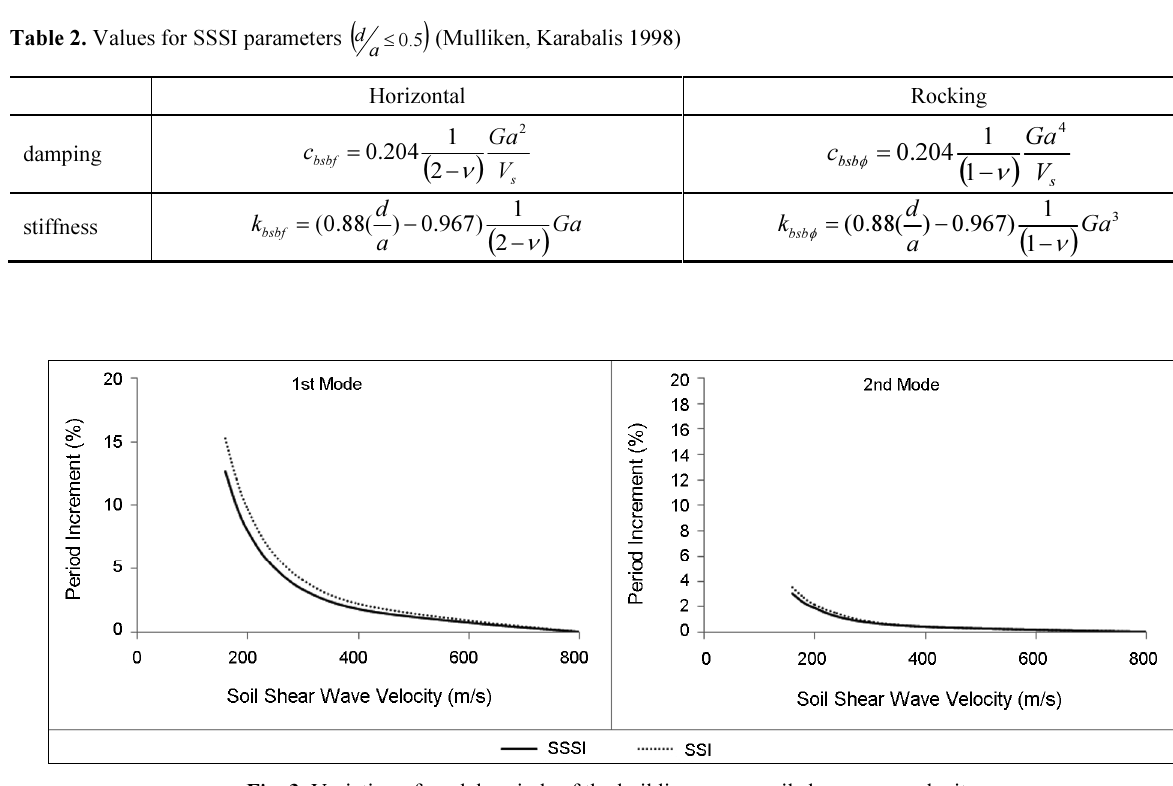
Fig. 3. Variation of modal periods of the building versus soil shear wave velocity